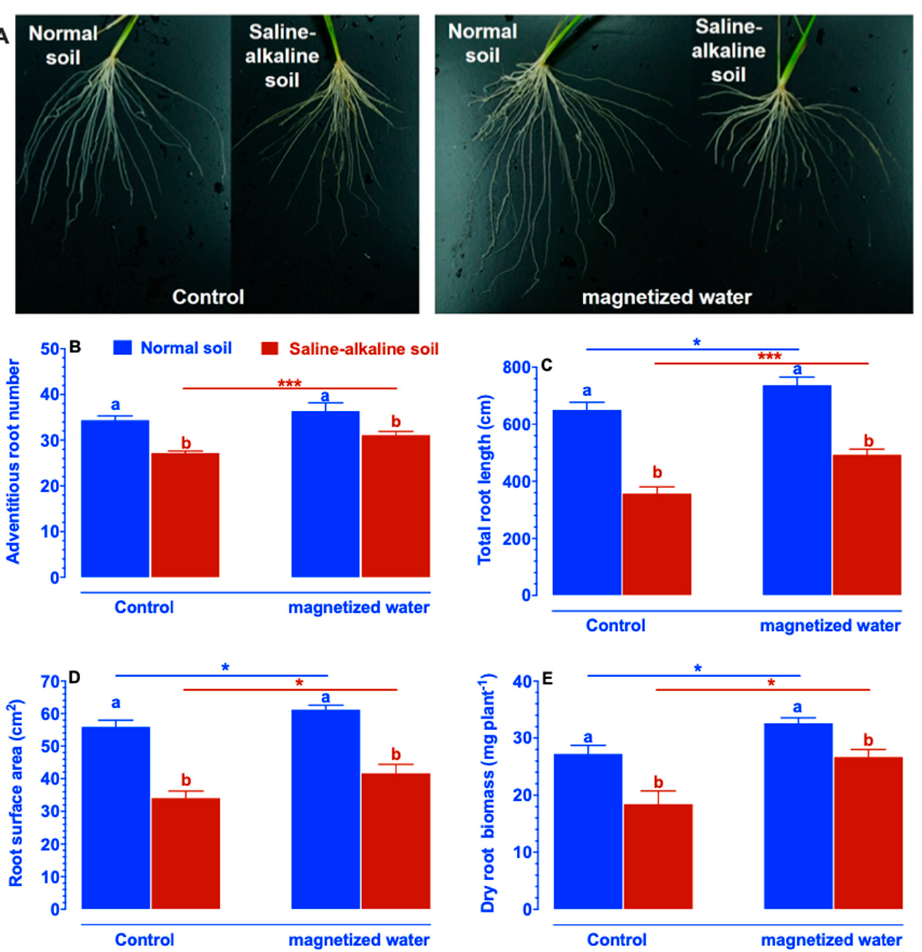
Figure 4. Effects of magnetized water on the root system architecture of Nipponbare plants grown in normal and saline–alkaline stress soil. ( A ) Root phenotypes. ( B ) Adventitious root number. ( C ) Total root length. ( D ) Root surface area. ( E ) Dry root biomass. Treatments were as described in Figure 1. Means with different letters are significantly different ( p < 0.05) within the same treatment. Asterisks indicate significant differences between control and saline–alkaline stress of the same genotype, as determined by Student’s t -test (* p < 0.05, *** p < 0.001).